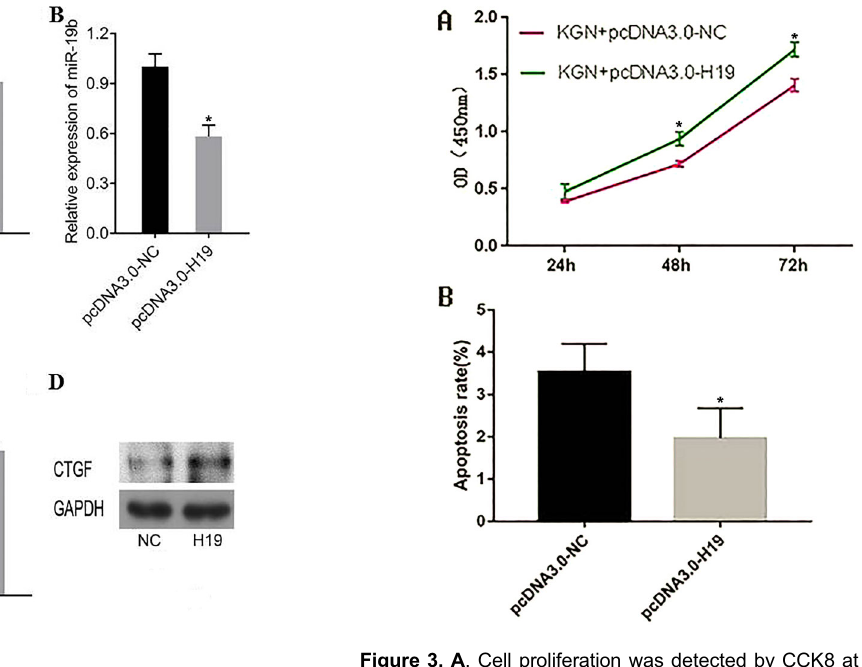
Figure 3. A , Cell proliferation was detected by CCK8 at 24, 48, and 72 h in KGN cells overexpressing H19 . B , Detection of KGN cell apoptosis by fl ow cytometry after overexpressing H19 . Data are reported as means ± SD. *P o 0.05 compared to negative control (NC) ( t